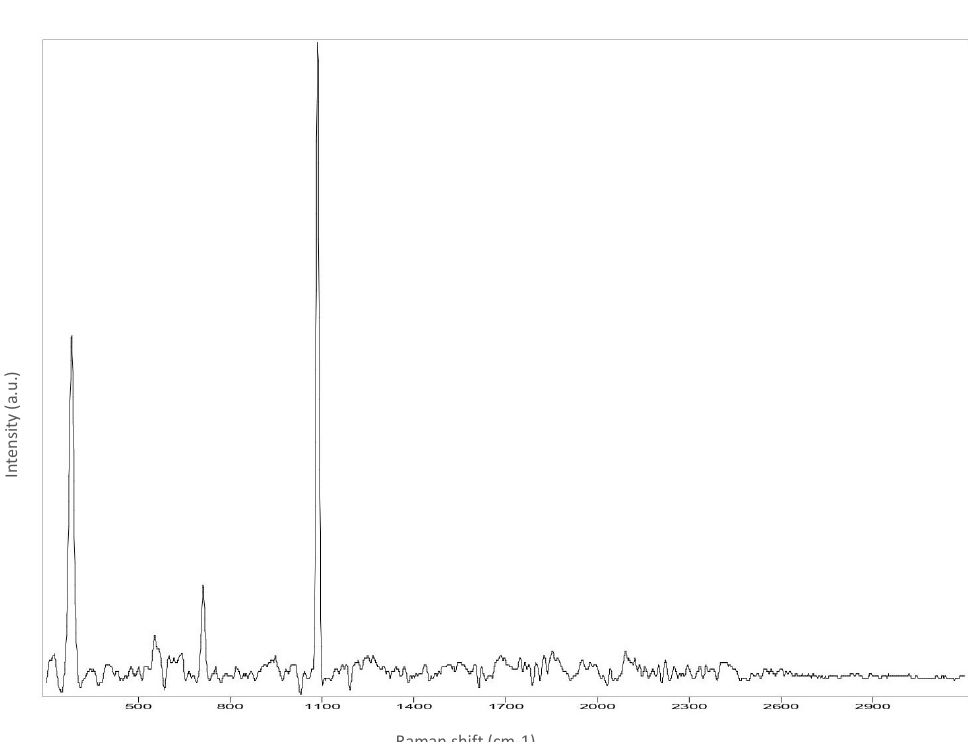
Figure A2. Back-right.